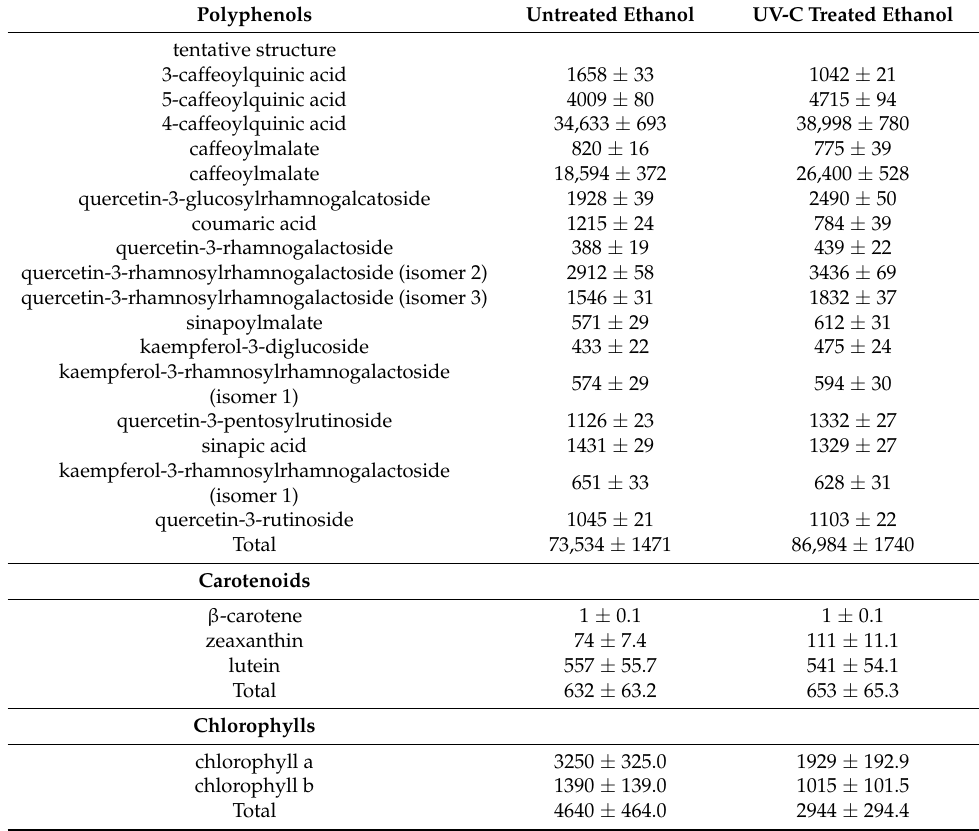
Table 3. Phytochemical content of extracts of untreated vs. UV-C treated S. scabrum in µ g/g DM (location C). The data are presented as phytochemical content ± average analytical